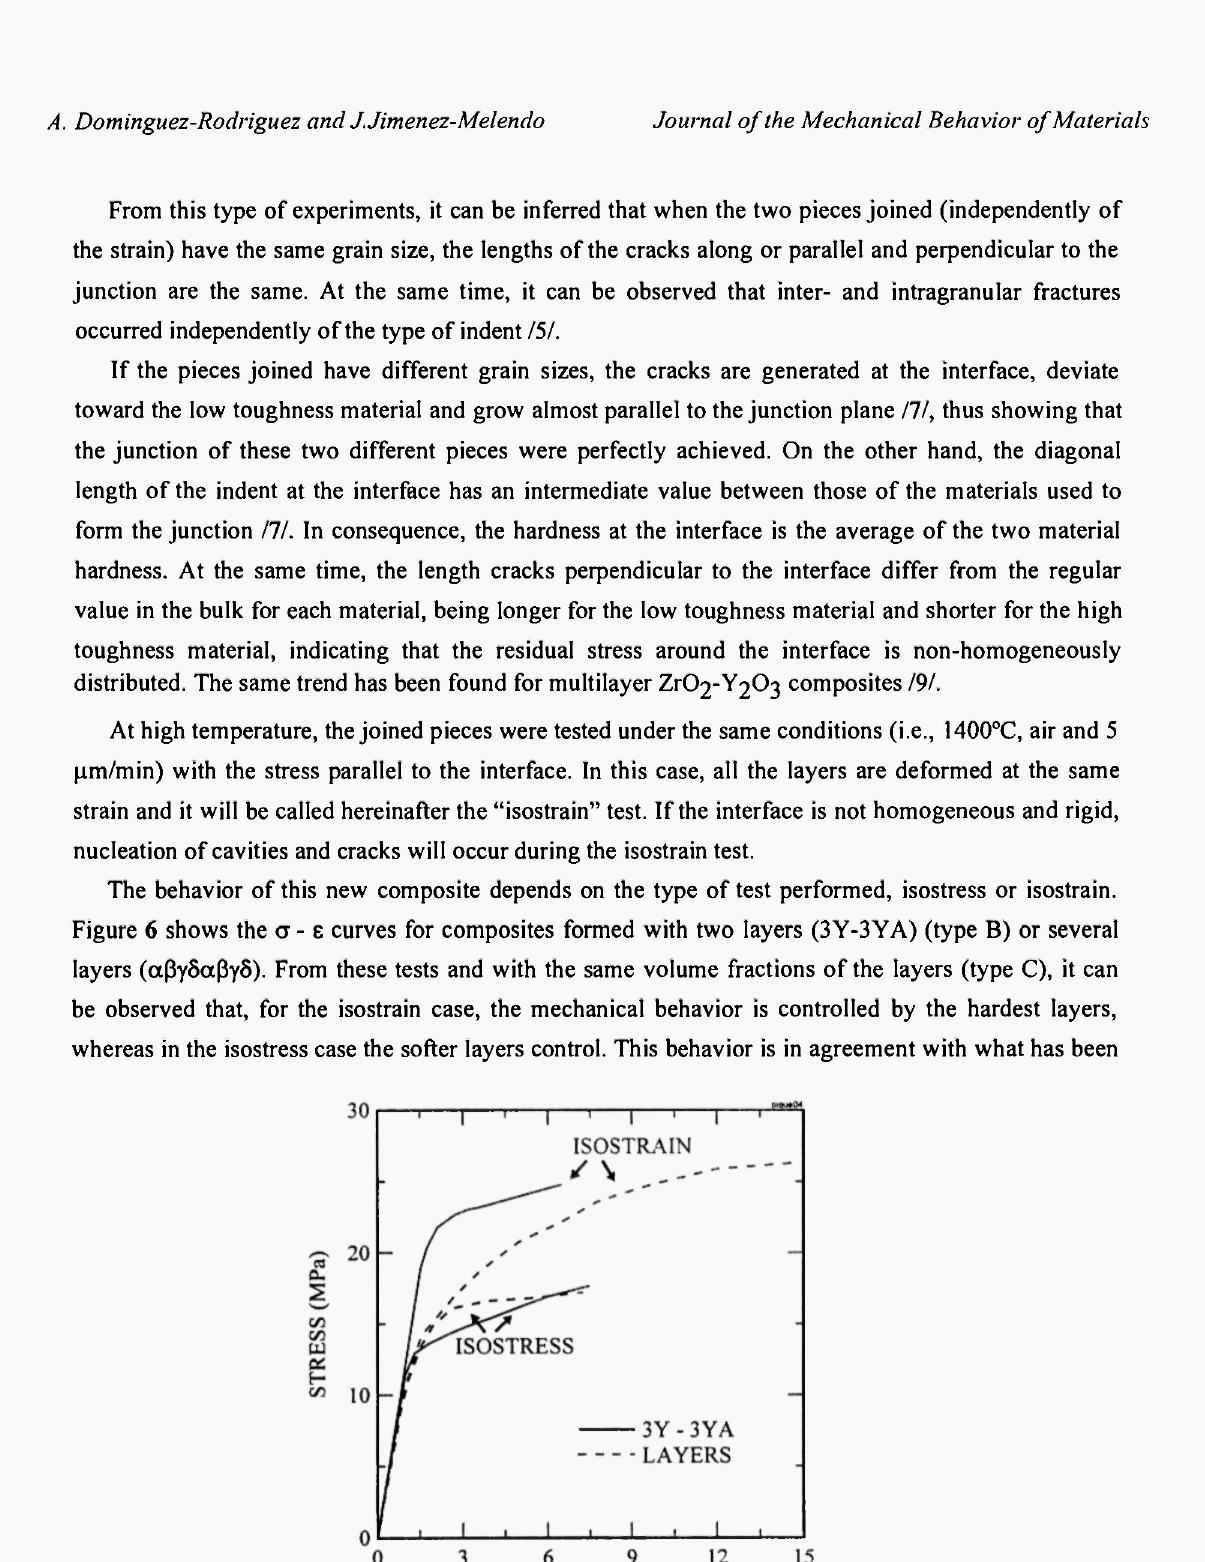
Fig. 6: σ - ε curves for 3Y-3YA (type B) and layered (type C) materials deformed under isostrain and isostress